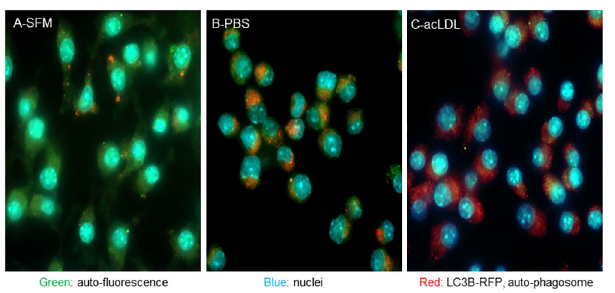
Fig 13. AcLDL induced auto-fluorescence puncta co-localize with auto-phagosome LC3 activity. J774A.1 cells were transfected with LC3B-RFP, and treated with AcLDL (C, 40 μ g/ml, 24 h), starved in PBS (B, positive control for autophagic induction, 2 h), or left in serum free media (A, negative control for autophagic induction), and imaged for auto-fluorescence shown in green, nuclei in blue, and LC3B-RFP distribution in red.